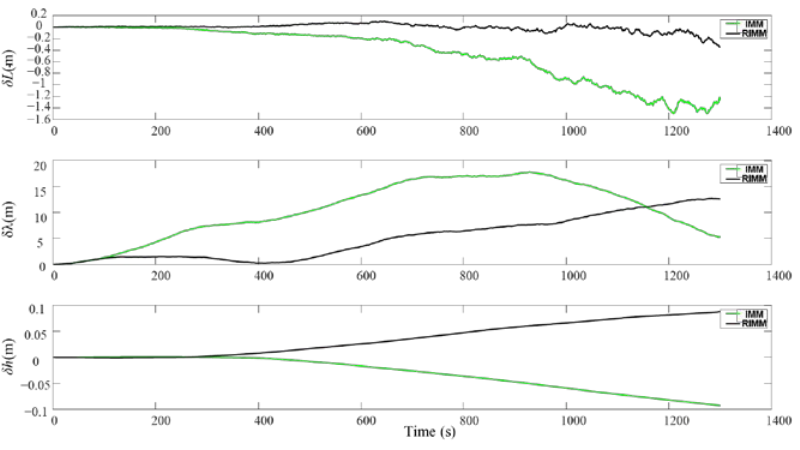
Figure 14. Position errors of RIMM and IMM.